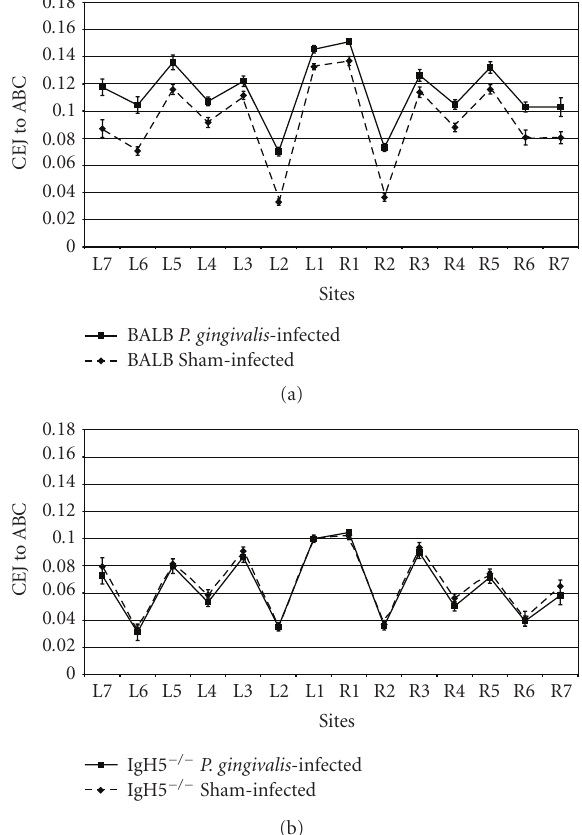
Figure 1: Changes in bone levels due to oral infection with P. gingivalis . The distance from the CEJ on the tooth to the ABC of the jaw was measured at 14 buccal sites on the maxillary molars, seven sites on the left (L) and seven on the right (R), with site number 1 located closest to the midline. Each point indicates the mean measurement at that site ± 1 SEM ( n = 10 mice). (a) Immune normal BALB/cJ mice showed alveolar bone resorption when infected with P. gingivalis . The distances from the CEJ to the ABC were significantly larger in infected mice than in sham-infected mice ( P < . 05) at each of the 14 sites, indicating that alveolar bone resorbed at every measurement site. (b) IgD deficient IgH5 − / − mice did not show alveolar bone resorption. The distances from the CEJ to the ABC were the same in P. gingivalis -infected mice as in sham- infected mice ( P > .